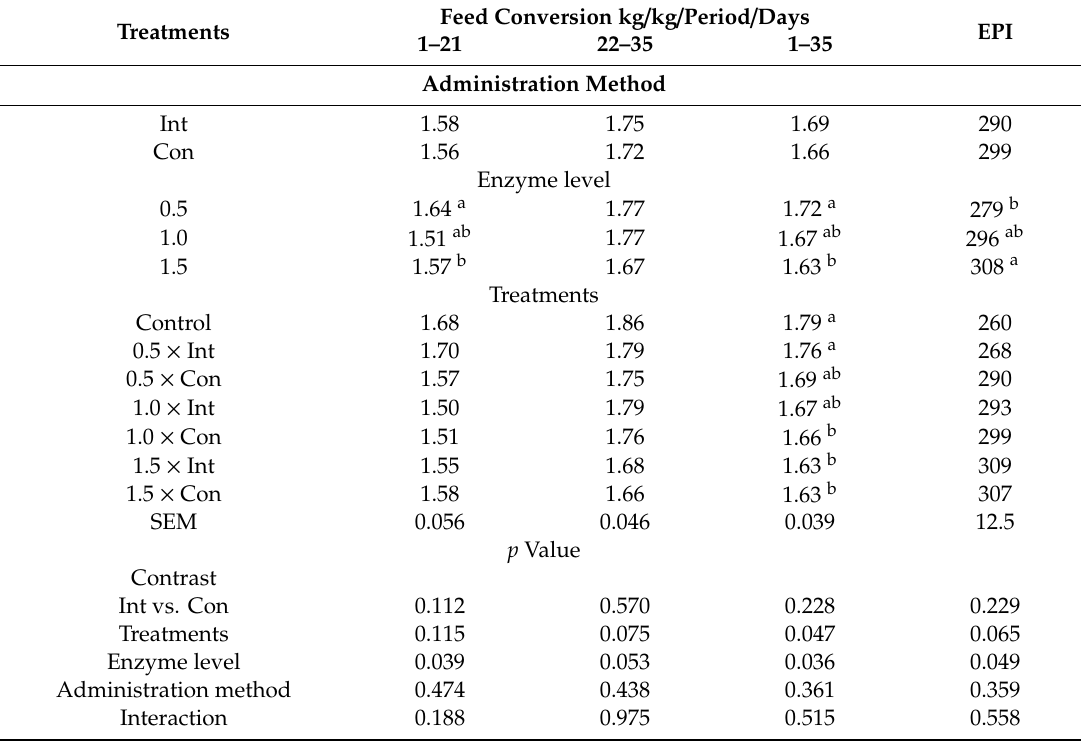
Table 3. E ff ects of multienzyme supplemented continuously or intermittently on feed conversion ratio and European production index of Arbor Acres broiler chicks during 1–35 days of